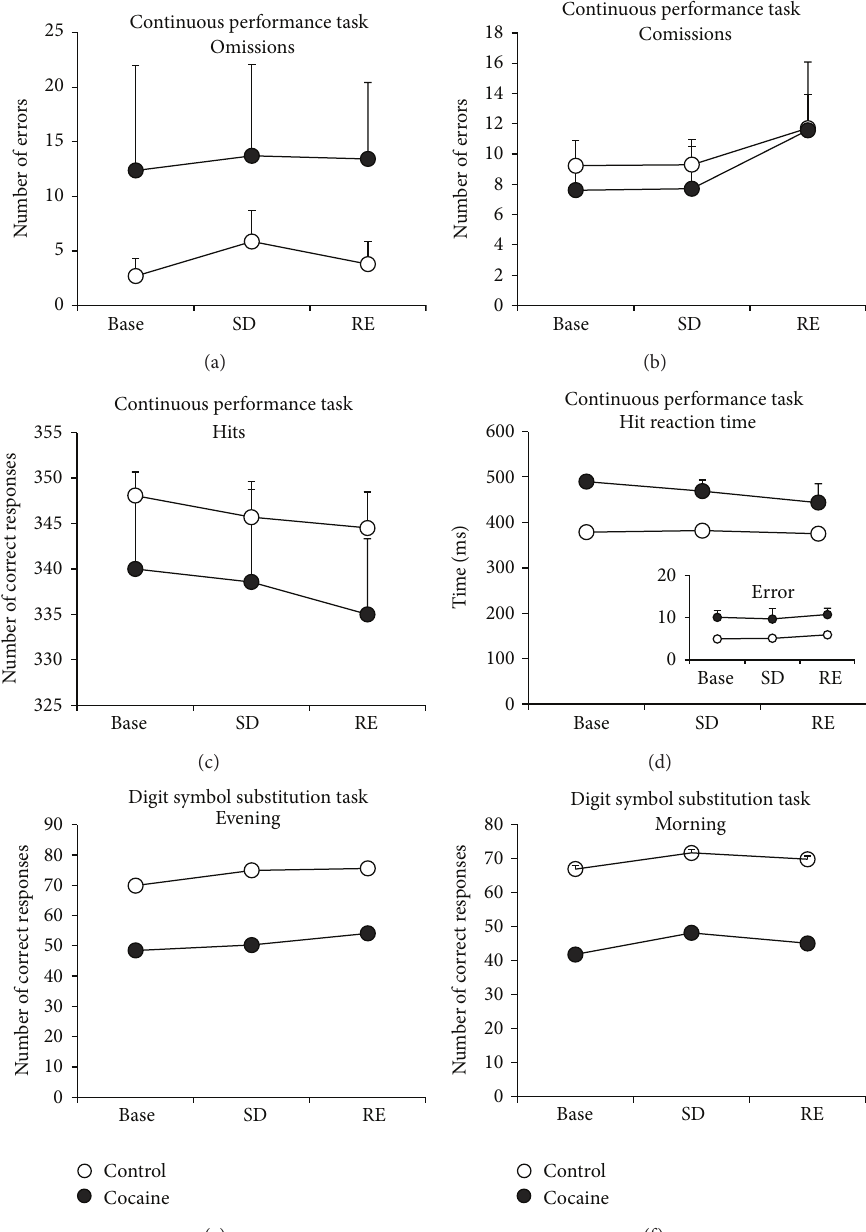
Figure 3: Differences between healthy control (control) and cocaine-dependent (cocaine) participants on Continuous Performance Task and for the Digit Symbol Substitution Task. The number of errors of omission (a) number, errors of commission (b), and the number of correct responses (hits; (c)), the hit reaction time (RT; (d)) hit RT standard error ((d) inset) on the CPT. The number of correct substitutions on the DSST as measured in the evening (e) and morning (f) of baseline (base; 8 hour time on bed), actively prolonged wakeful state following sleep deprived (SD), and recovery (RE; 8 hour time on bed) sleep.